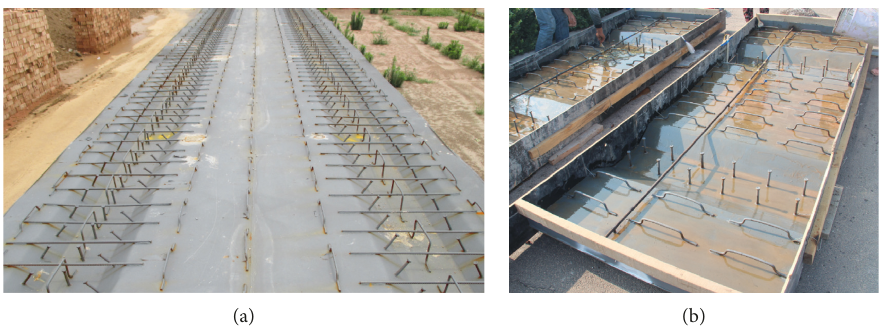
Figure 2: Steel member of SCC slabs (a) In a real bridge (b) In a test